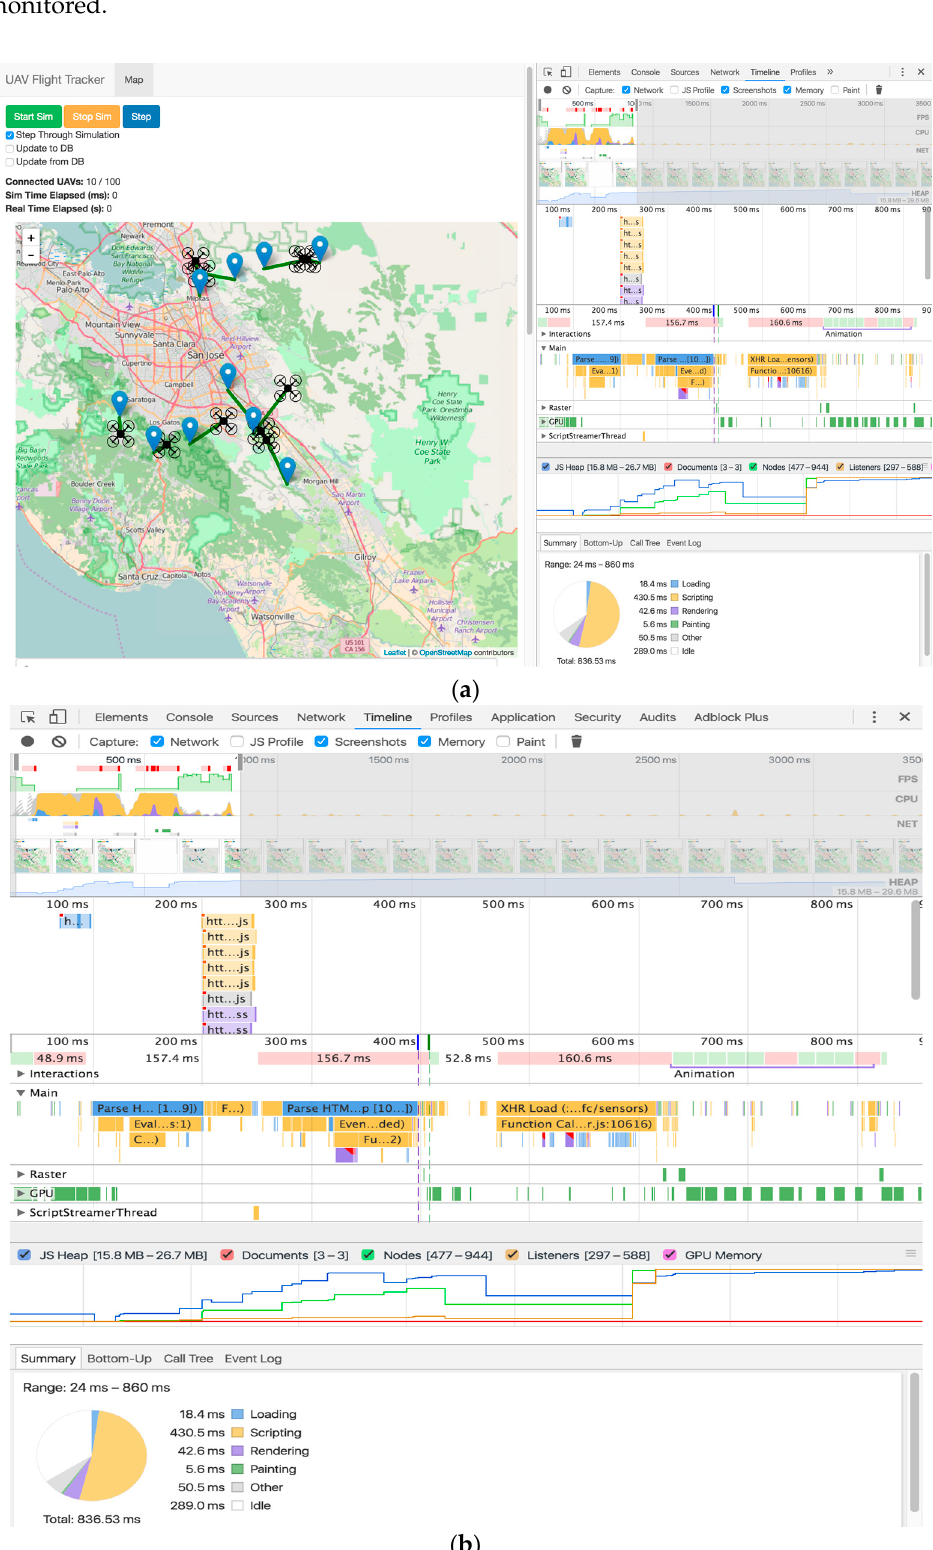
Figure 8. Client performance testing results by Chrome DevTools: ( a ) screen of client system with performance results and ( b ) performance results.